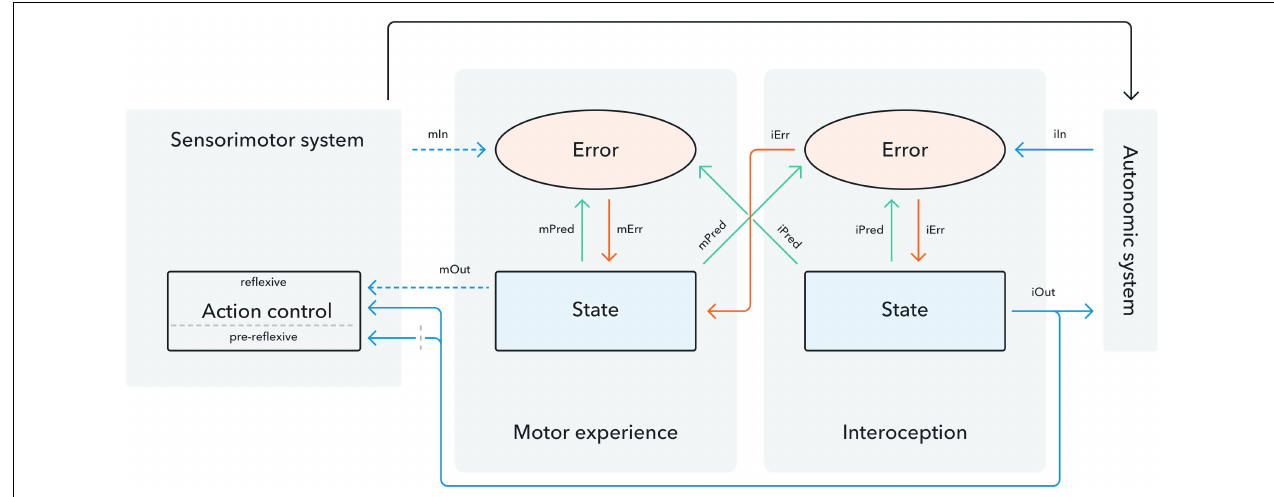
FIGURE 1 | Graphical representation of the interaction between interoception and motor actions (adapted from Seth et al., 2012). Predictions relating to interoception and motor experience are generated in the state module. They are passed to the error module where they are compared to the afferent input relayed from the sensorimotor system for actions and the autonomic system for interoceptive states. The resulting error mismatch signal is sent back to the state module where it is processed to translate into a heightened or reduced sense of action ownership or interoceptive embodiment. We further propose three potential pathways in which interoceptive input could influence motor experience: (1) Interoceptive predictions [iPred] contribute to the experience of motor states. (2) The overall interoceptive state [iOut] transmits continuous information to the sensorimotor system (the overall motor state [mOut] transmits a transitory signal). (3) Continuous interoceptive information is used for reflexive forms of action control (the gray dotted barrier indicates that interoceptive input is received but is not necessary for pre-reflexive action